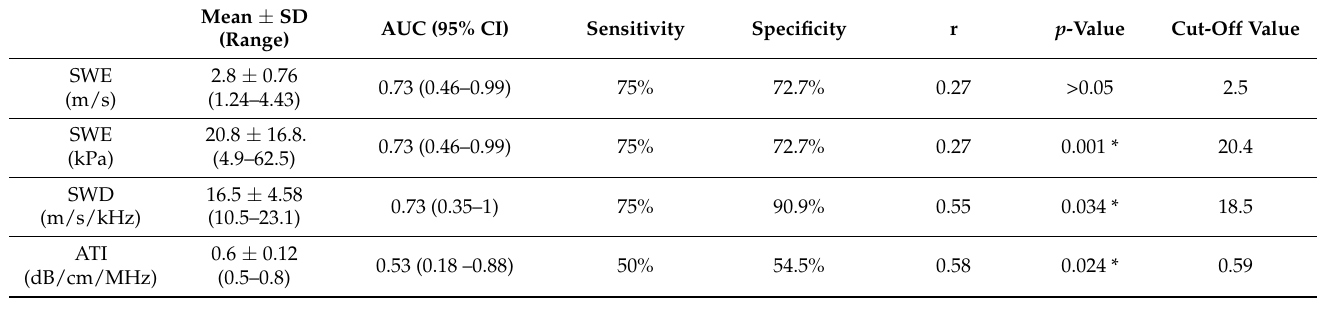
Table 1. Overview of the quantitative analysis results of SWE, SWD and ATI and the corresponding statistical analysis results of ROC/AUROC analysis, Pearson’s coefficient and t -test application for paired samples. A p -value < 0.05 was considered statistically significant (*). Sensitivity and specificity rates are based on the calculated cut-off value.